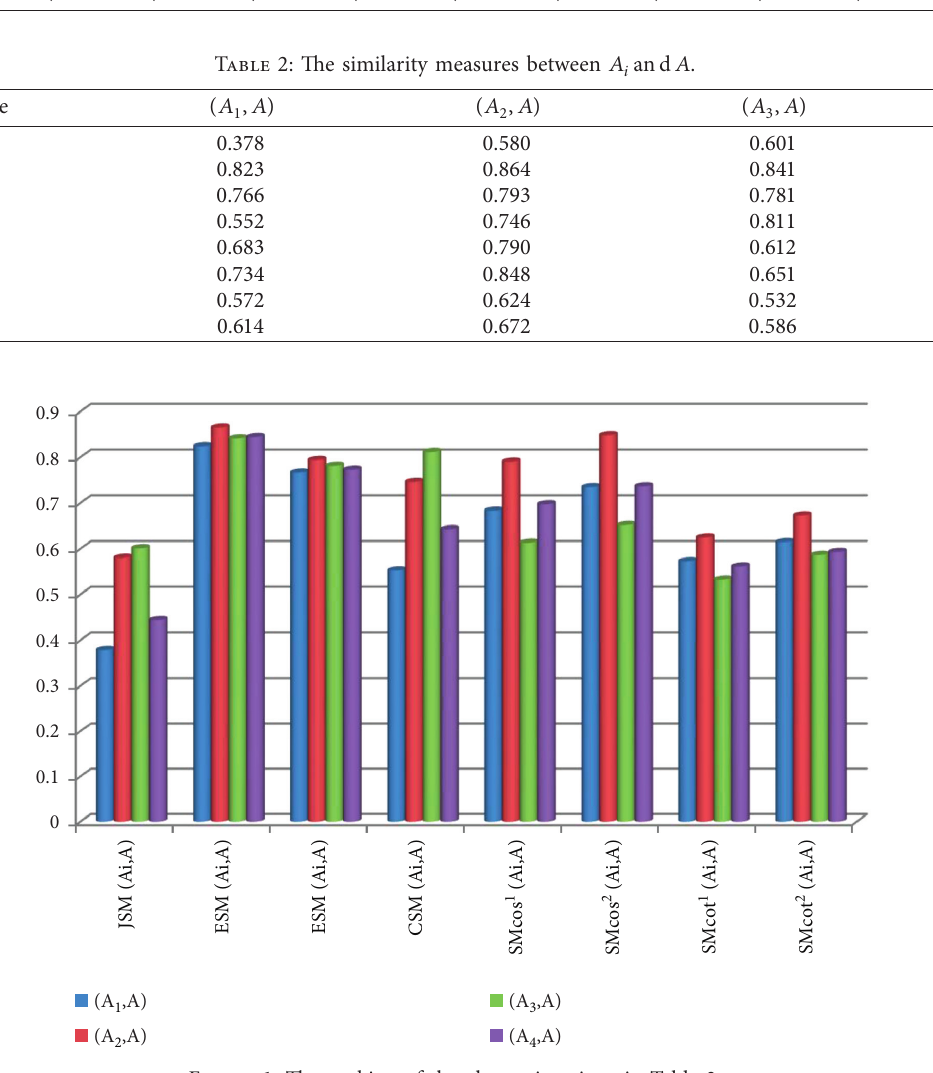
Figure 1: The ranking of the alternative given in Table 2.